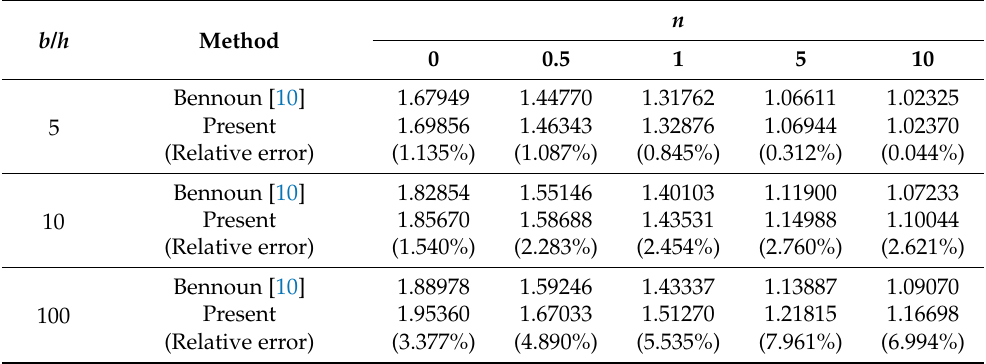
Table 4. Comparison of calibrated fundamental frequencies, ω , for simply supported square FG sandwich plates with homogeneous hardcores